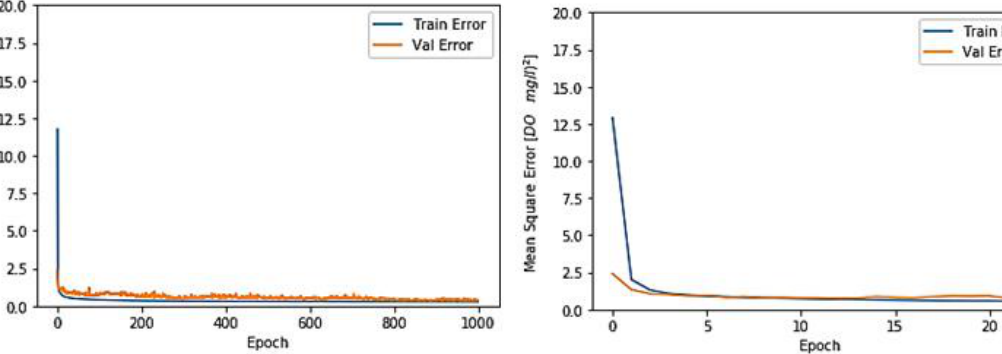
Figure 10. Mean square error (Toichio station, structure 7-32-32-1)